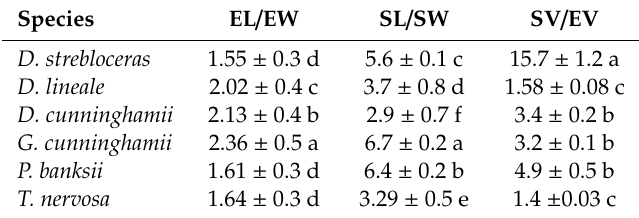
Table 3. Calculated ratios for embryo length to embryo width (EL / EW), seed length to seed width (SL / SW), and seed volume to embryo volume (SV / EV) for six orchid species and post-hoc comparisons after a